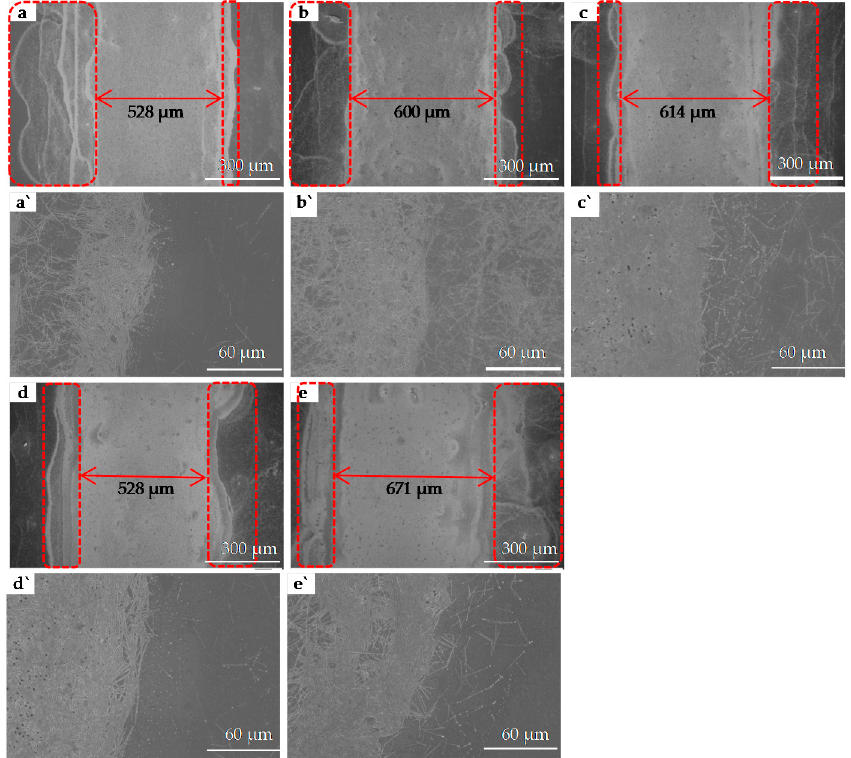
Figure 9. SEM images of the red frame in Figure 8 from the printed patterns ( a) to ( e ), and ( a‘ – e‘ ) are the corresponding local magnifications.